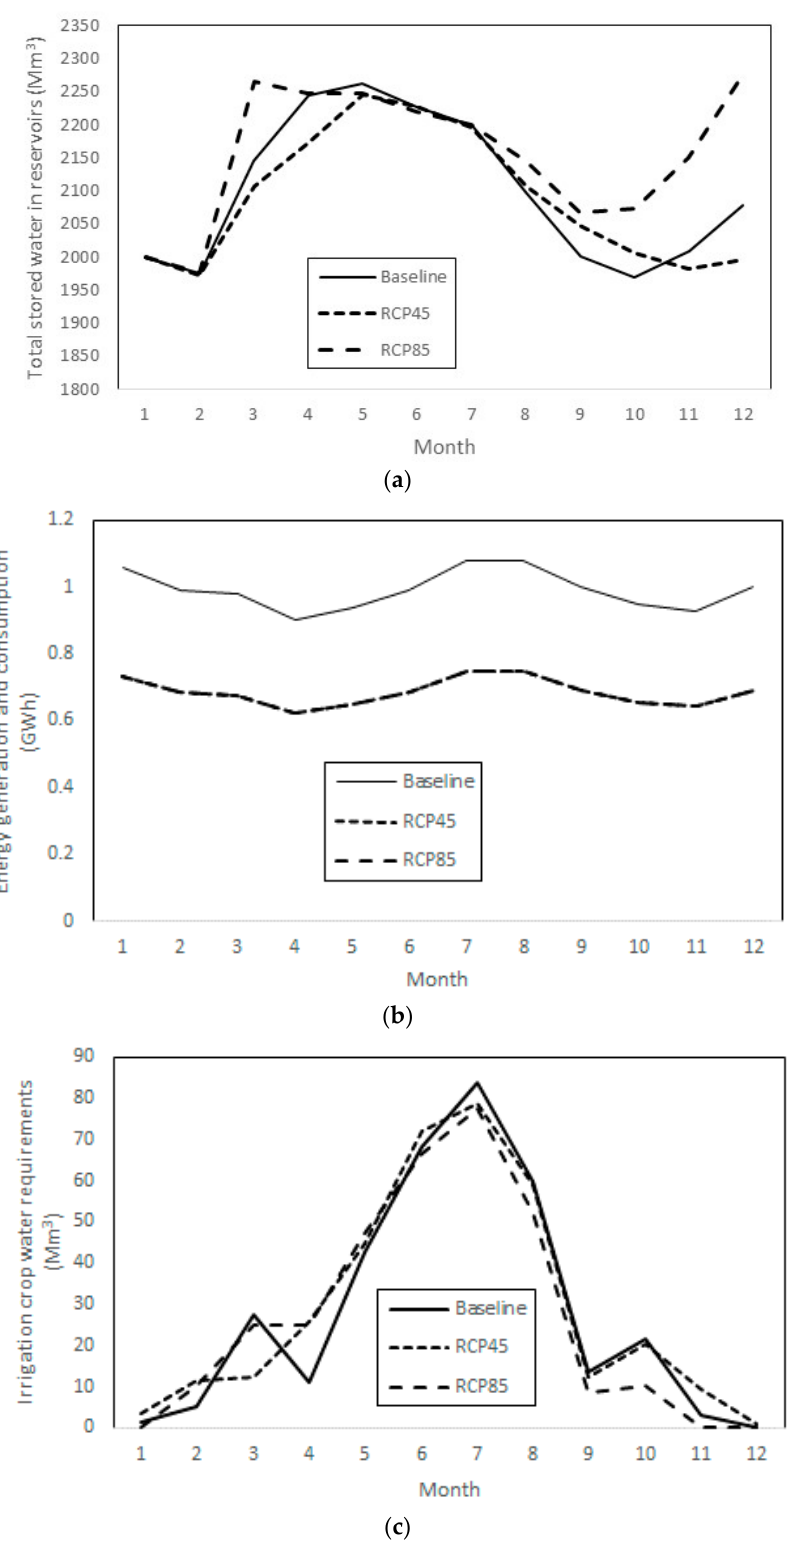
Figure 8. ( a ) Showing the results of the Sardinia fast-track simulation for the baseline (2010) and for 2030 under RCP4.5 and 8.5. Results show the total water stored in all Sardinian reservoirs. ( b ) Energy generation and consumption for the baseline and both RCP scenarios. Energy generation equals consumption in each month. The predicted generation/consumption in the RCPs are the same. ( c ) Irrigation crop water requirements.